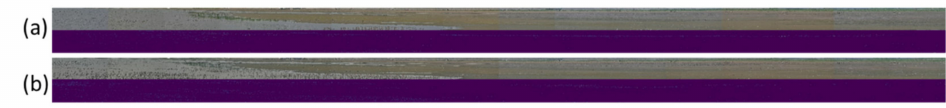
Figure 2. Samples of the dataset. We show two samples ( a , b ) from the dataset, where each sample consists of the original image (upper) and the ground truth